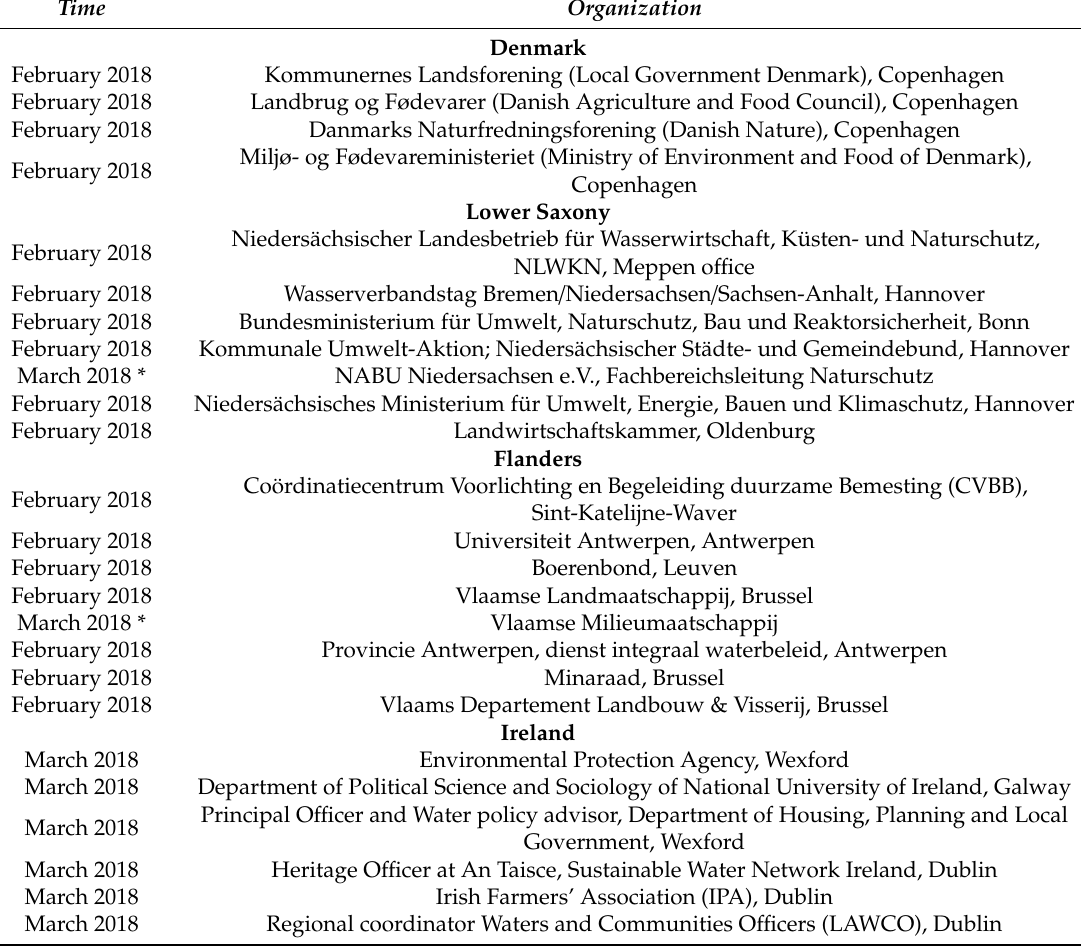
Table A1. List Interview Respondents Comparative Study WFD (Made